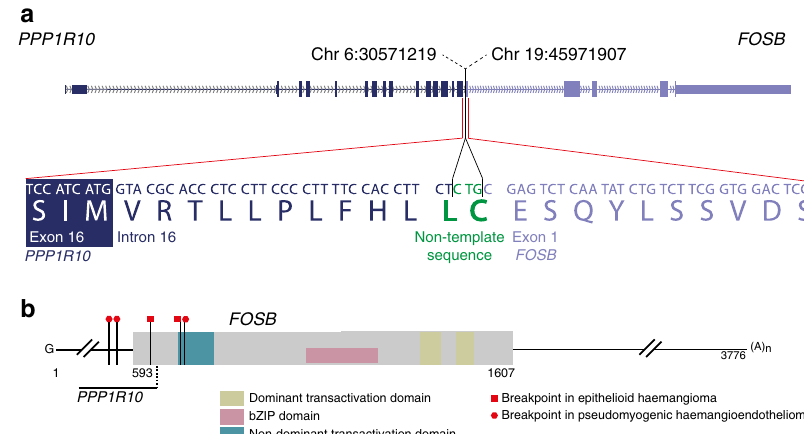
Fig. 2 FOSB fusion in PD7525. a Schematic of the PPP1R10-FOSB fusion. The PPP1R10 exon 16 splice donor site is skipped, resulting in exonisation of part of the intron. A three-nucleotide non-template sequence at the break point then allows an in-frame PPP1R10-FOSB fusion transcript to be produced. b Annotated schematic of the wild-type FOSB transcript with the published break points in the vascular tumours (pseudomyogenic haemangioendothelioma (PHE), epithelioid haemangioma